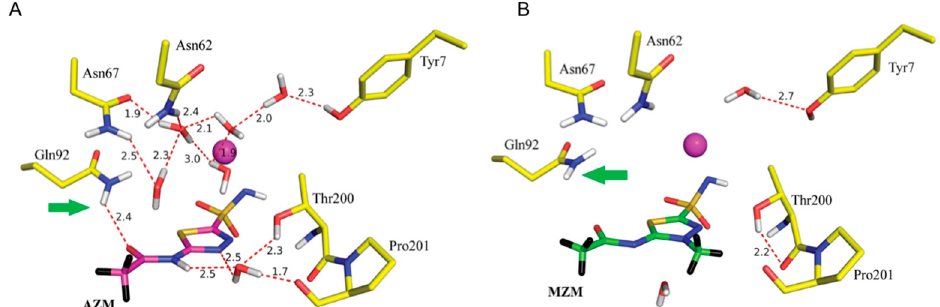
Figure 16. Comparison of AZM and MZM binding and water displacement as observed in neutron crystallographic studies. ( A ) AZM complex; ( B ) MZM complex [60]. Figure reproduced, with permission from the International Union of Crystallography from [60].